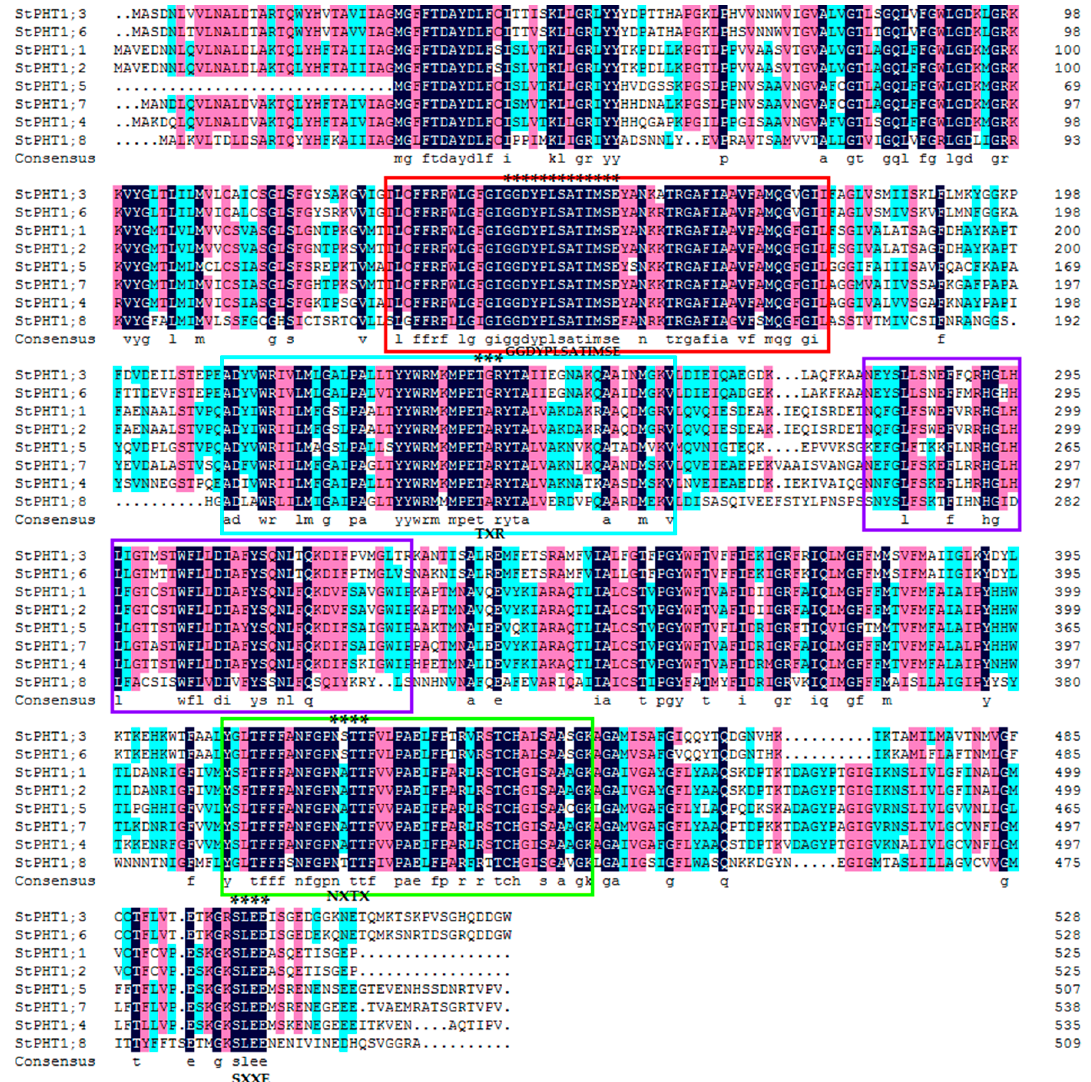
Figure 2. Potato PHT1 family protein sequence alignment. The amino acid sequence of the potato PHT1 protein was aligned using Clustal X 1.83. Amino acids marked in dark blue indicate 100% sequence identity, pink indicates ≥ 75% identity, and light blue indicates ≥ 50% identity. The boxes of different colors correspond to the motifs of the same color in Figure 1C. Asterisks (*) above the sequence indicate the [ST]-x-[RK] motif, N-{P}-[ST]-{P} motif, [ST]-x(2)-[DE] motif [38], and conserved amino acid sequence (GGDYPLSATIMSE) [39].